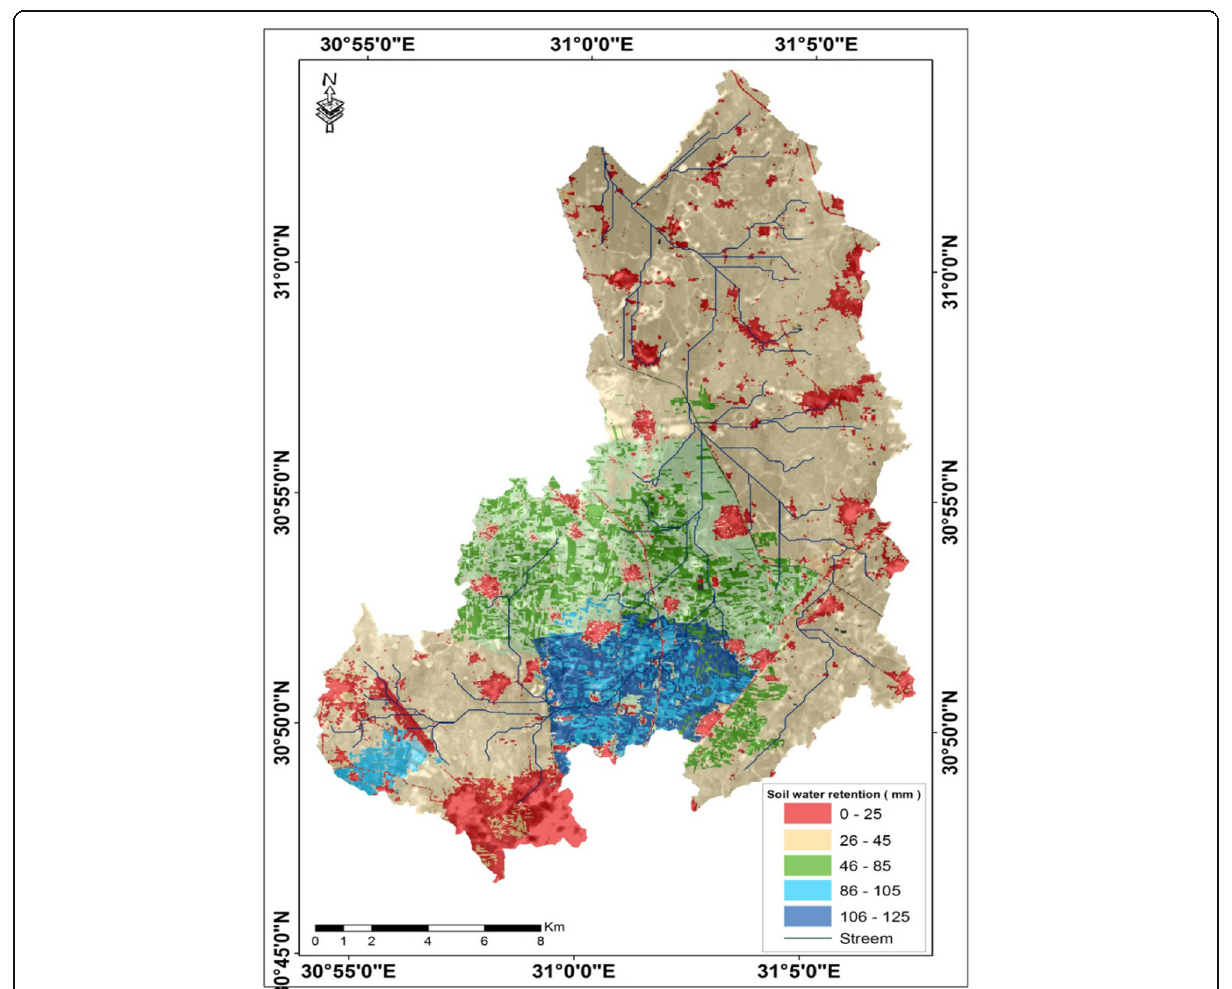
Fig. 6 Spatial distribution of the potential water